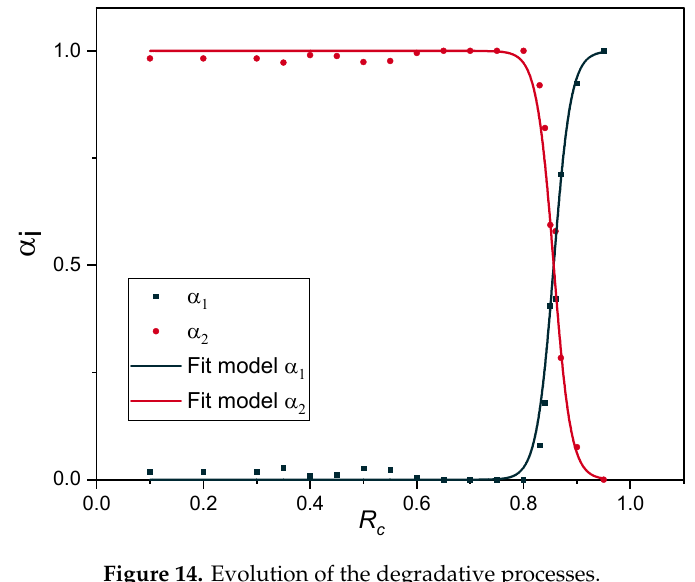
Figure 14. Evolution of the degradative processes. Table 4. Fit parameters of the fraction of